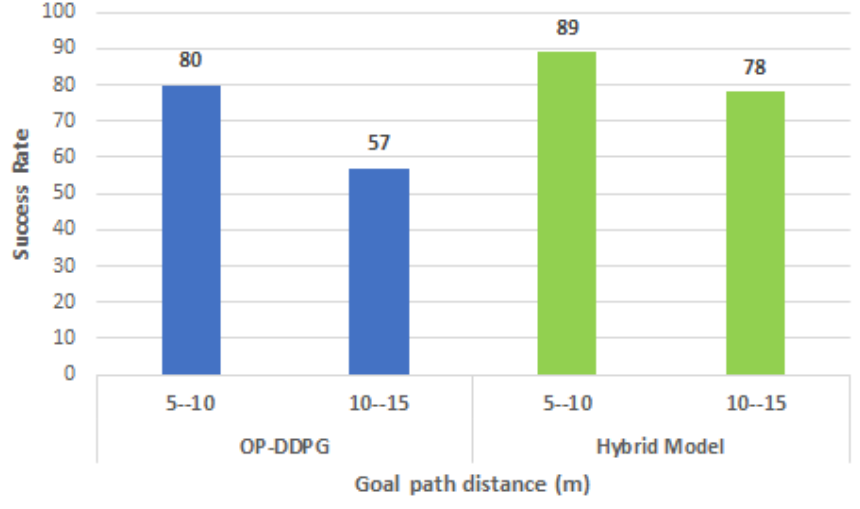
Figure 5. Success rate variation with distance in Building 2. The graphic shows less rate decay with path distance in the hybrid model (green bars) with 20 moving